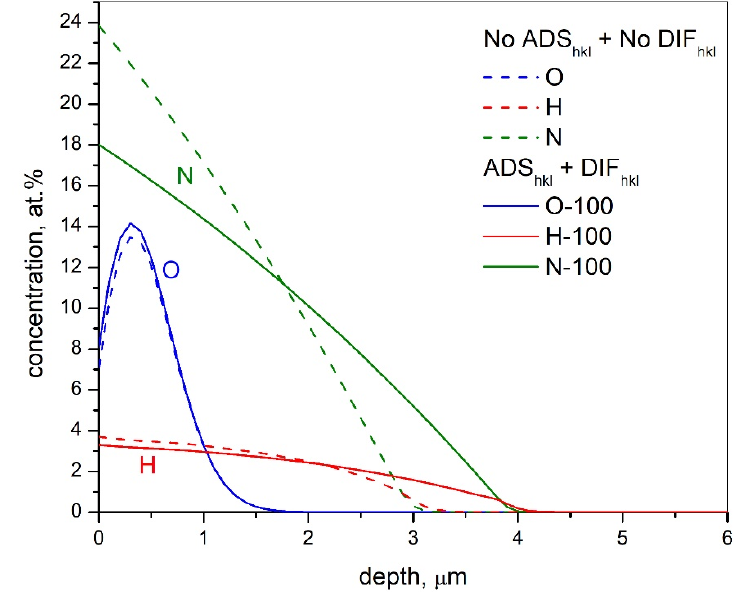
Figure 4. Depth profiles of nitrogen (N), hydrogen (H) and oxygen (O) calculated for two different cases: (1) isotropic (No ADS hkl + No DIF hkl ) and (2) anisotropic (ADS hkl + DIF hkl ) surface processes and diffusion.